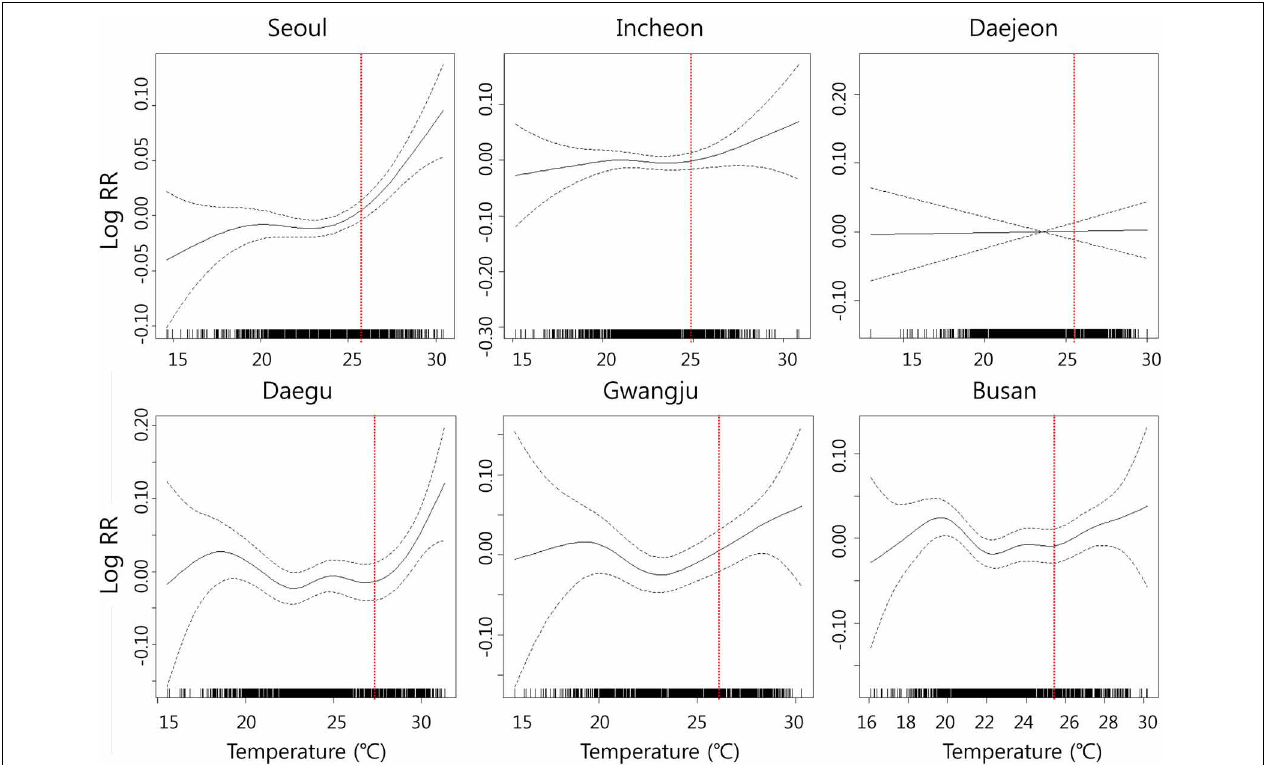
FIGURE 2 | Penalized regression splines for all-cause mortality on daily mean temperature for summer (June to September in 2001–2008). Each figure shows the spline curve (the solid line) with a 95% confidence interval